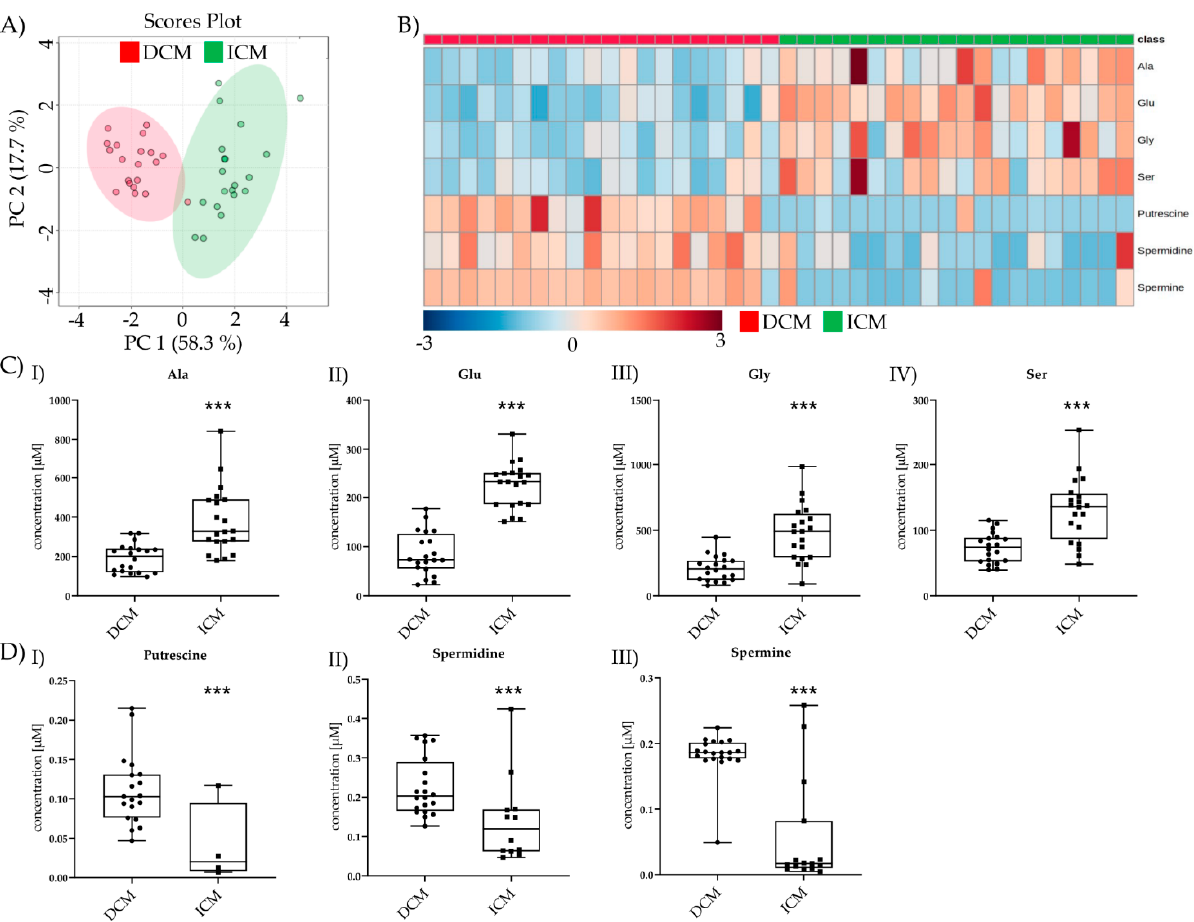
Figure 3. Comparison of significant metabolic parameters of DCM and ICM pre-LVAD. ( A ) PCA of pre-LVAD DCM vs. pre-LVAD ICM significantly different metabolites. ( B ) Heatmap visualization of the seven metabolites significantly different between DCM and ICM pre-LVAD. ( C ) I–IV Amino acid levels of pre-LVAD DCM vs. pre-LVAD ICM. Depicted are min, max, median, and single values. Significance was calculated with a t -test) or the Mann–Whitney U test). * indicates significant to DCM (*** = p < 0.001) ( D ) I–III Biogenic amine levels of pre-LVAD DCM vs. pre-LVAD ICM. Depicted are min, max, median, and single values. Significance was calculated with a t -test or the Mann–Whitney U test. * indicates significant to DCM (*** = p < 0.001)